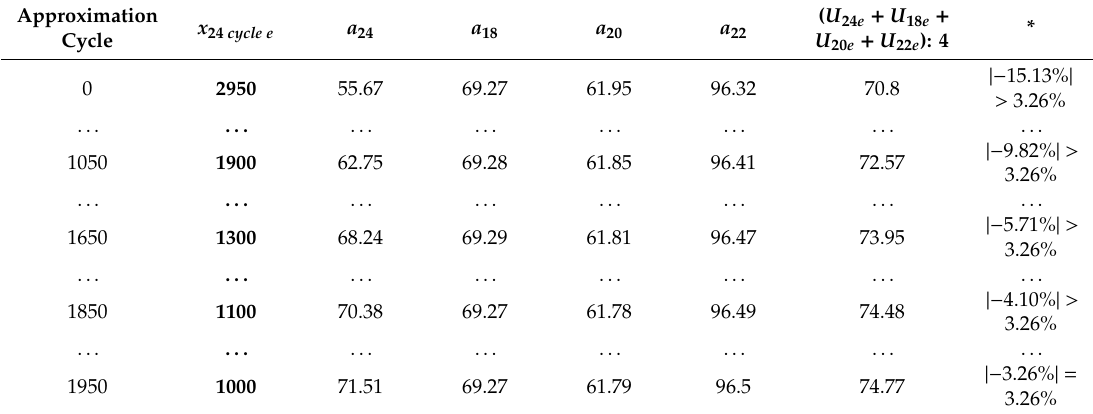
Table 5. The integrated hedonic–utilitarian value x 24 cycle e that would make the dwelling project